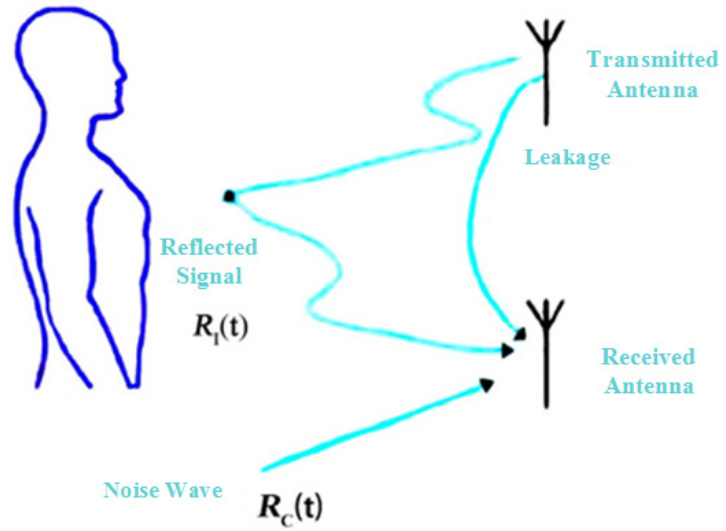
Figure 8. Transmitting antenna